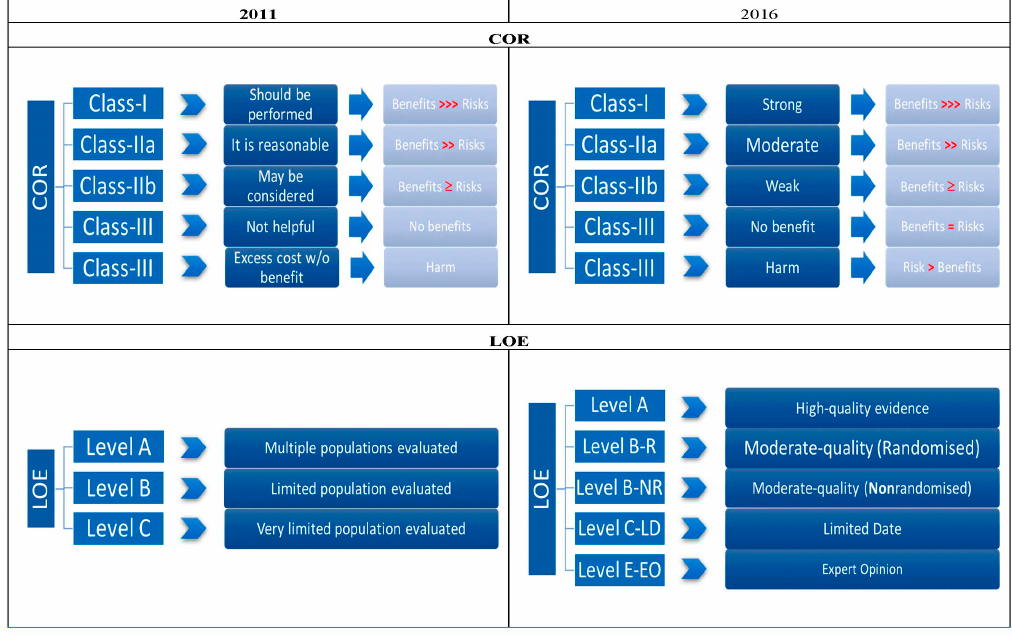
Figure 1. Comparison between guidelines 2011 and 2016 in terms of class of recommendations (COR) and level of evidence (LOE).